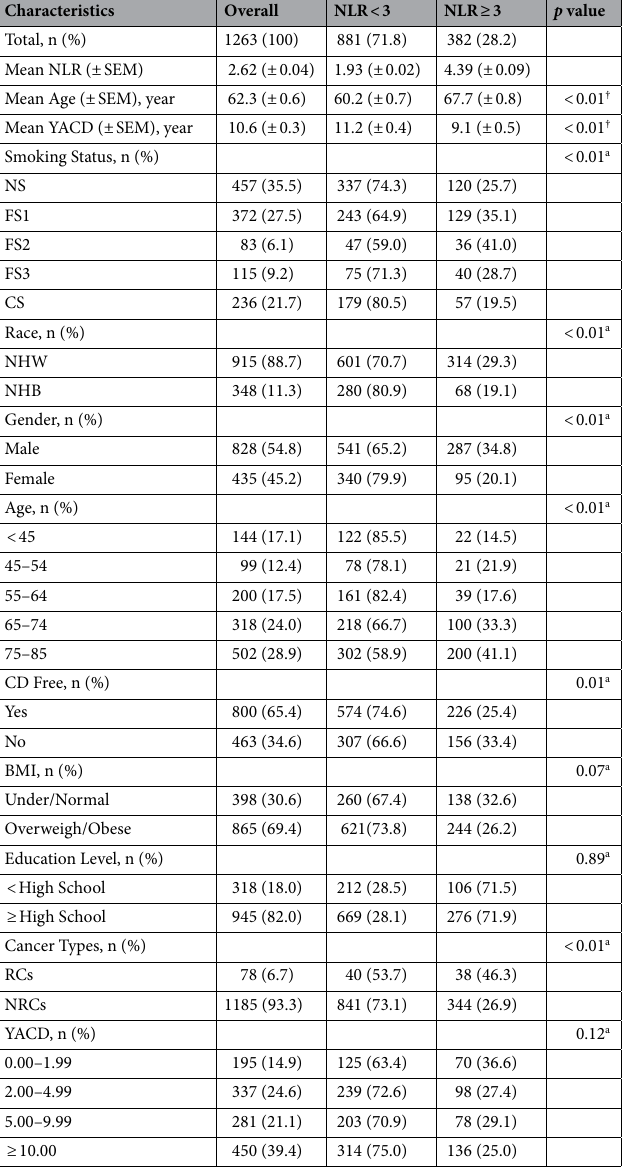
Table 1. Characteristics of 1263 cancer survivors with different NLR risks using NHANES 1999–2018 Data. † One-way ANOVA test found mean age is distributed differently between low-risk and high-risk NLR